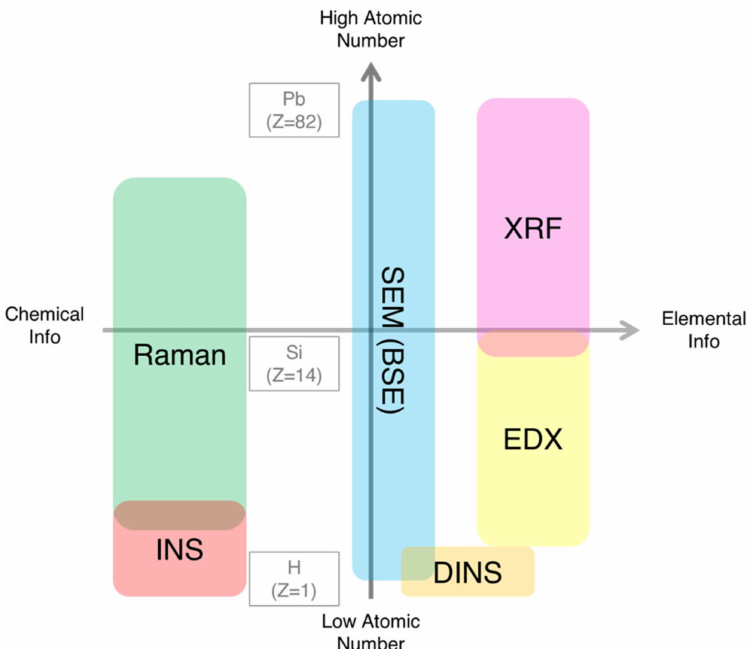
Figure 8. Schematic describing the kind of information available from each technique (chemical or elemental) and the dependence on the atomic number, highlighting the complementarity of the techniques involved in the